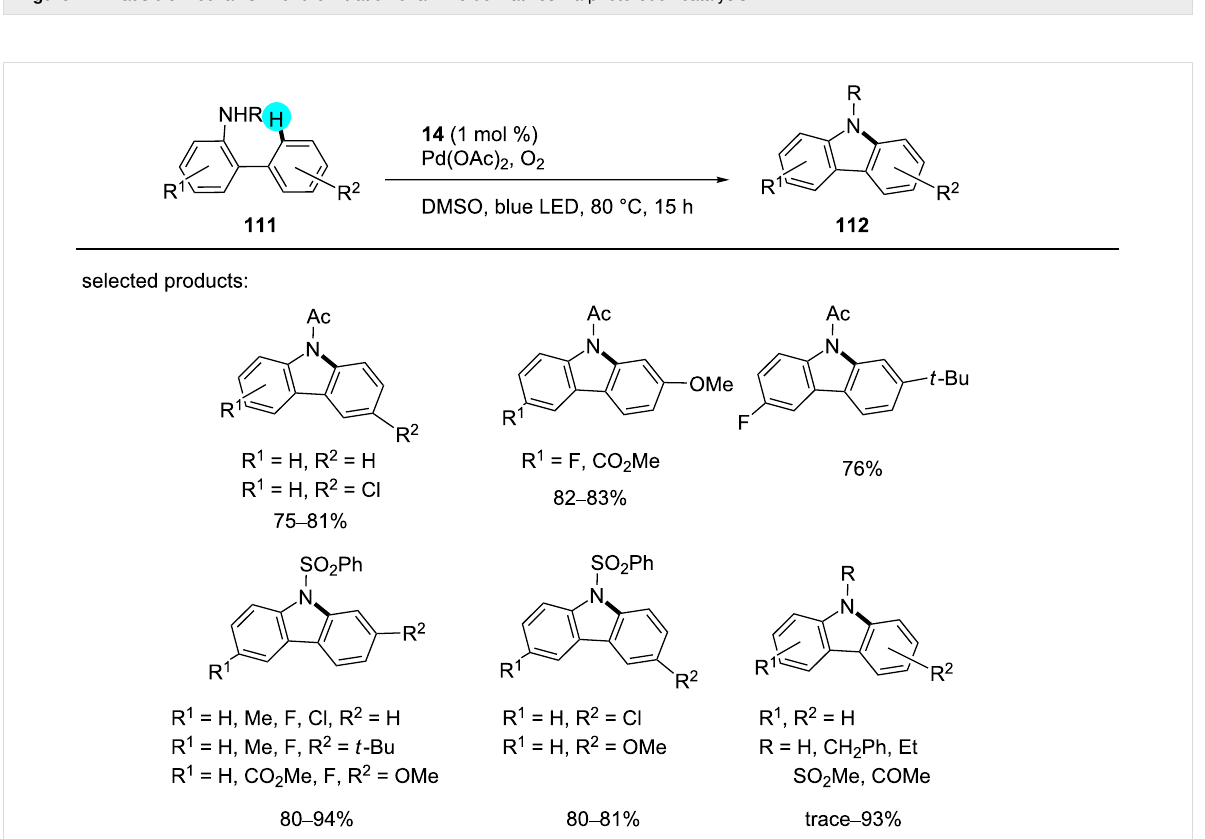
Figure 17: Plausible mechanism for the nitration of aniline derivatives via photoredox catalysis.